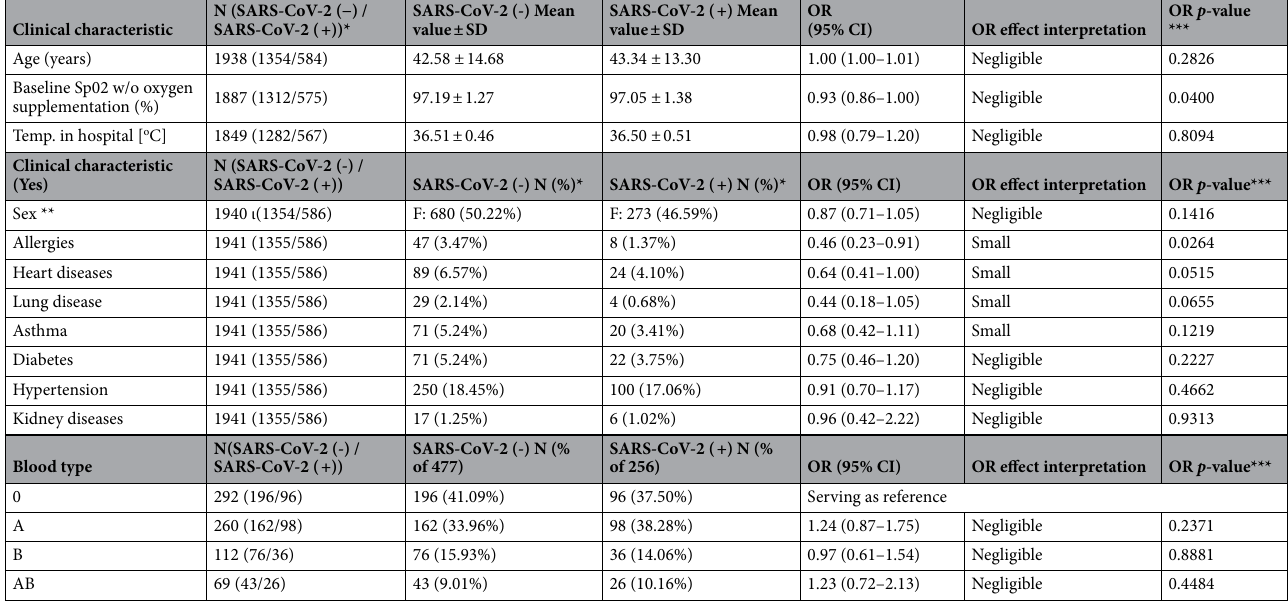
Table 2. The differences in prevalence of studied clinical characteristics between patients positive and negative for SARS-CoV-2. * % calculated referring to N of particular characteristics in SARS-CoV-2(-) and SARS- CoV-2( +). ** Characteristics for sex were provided considering men as reference. *** Unadjusted p